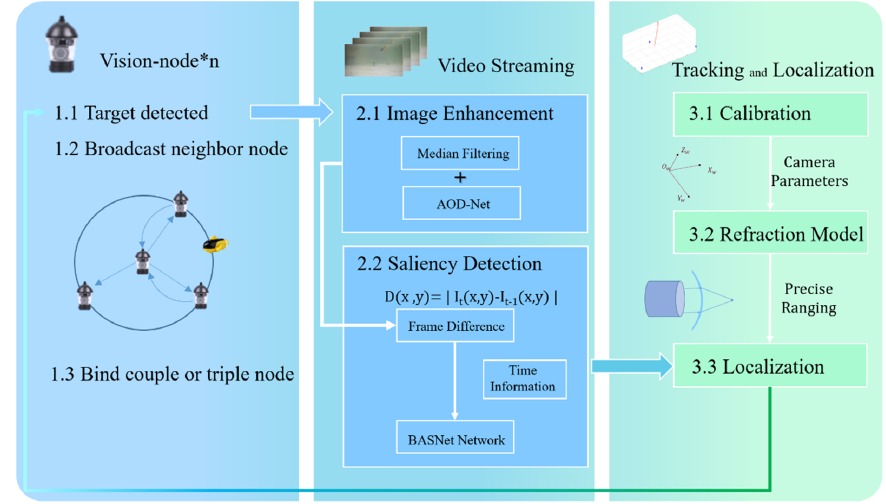
Figure 1. System flow chart.